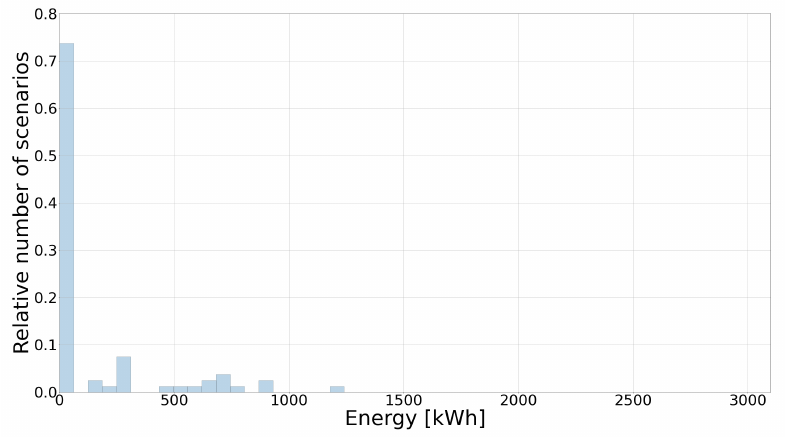
Figure 19. Histogram of M R values for PV generation decreased by a factor of 0.8 and re-trained RL agent.